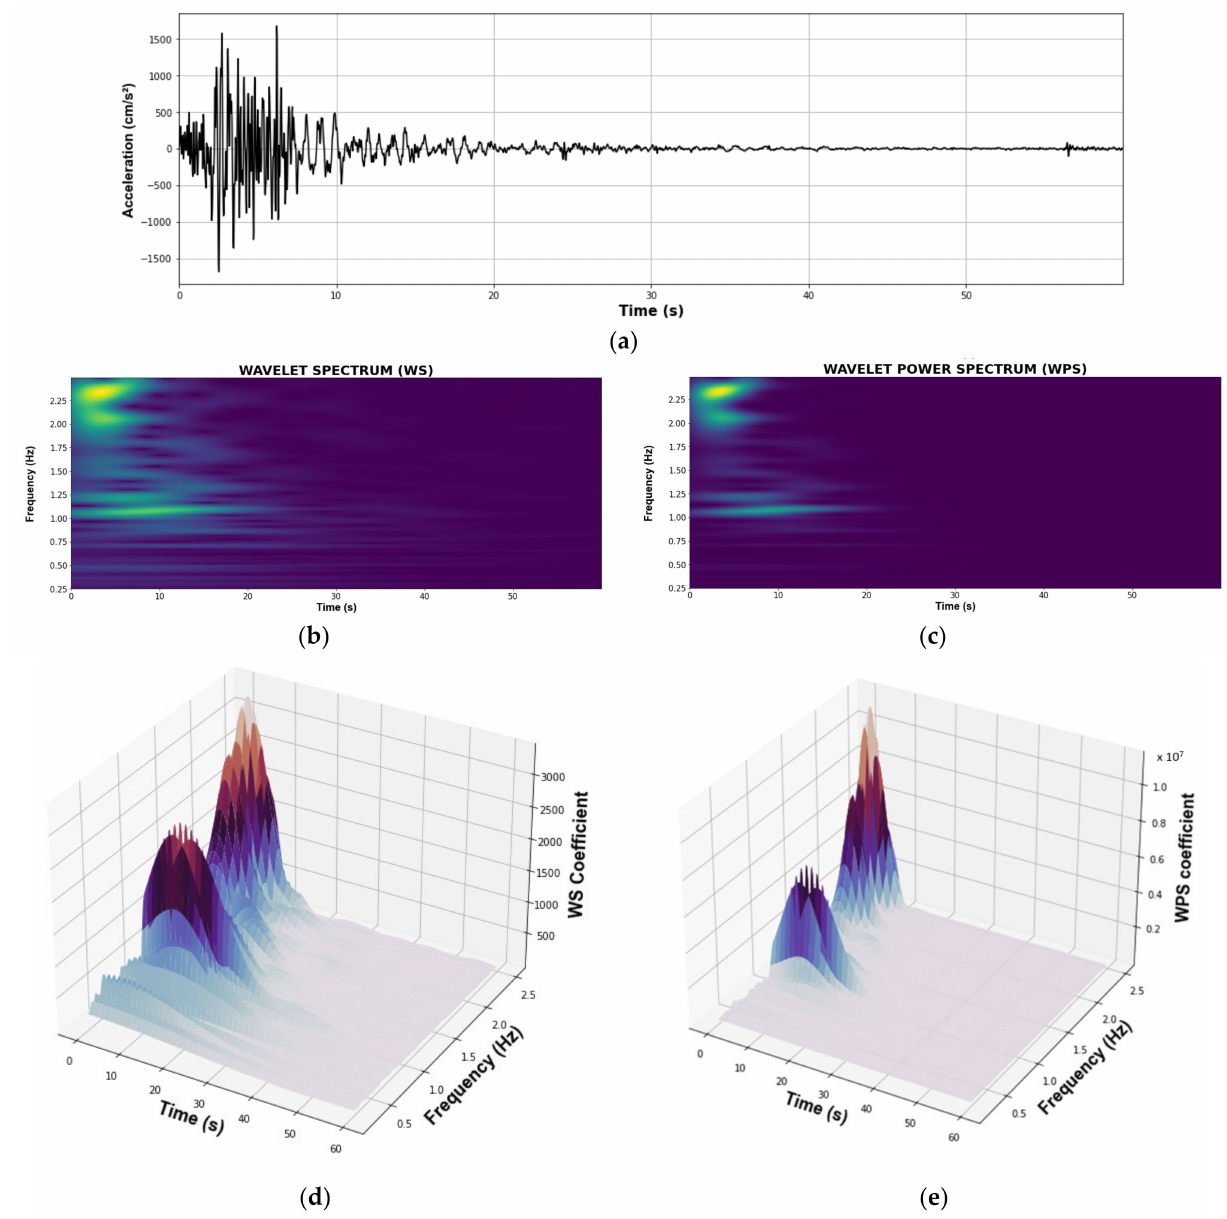
Figure 14. ( a ) Original signal; ( b ) two-dimensional WS; ( c ) two-dimensional WPS; ( d ) three-dimensional WPS; ( e ) three-dimensional WPS.